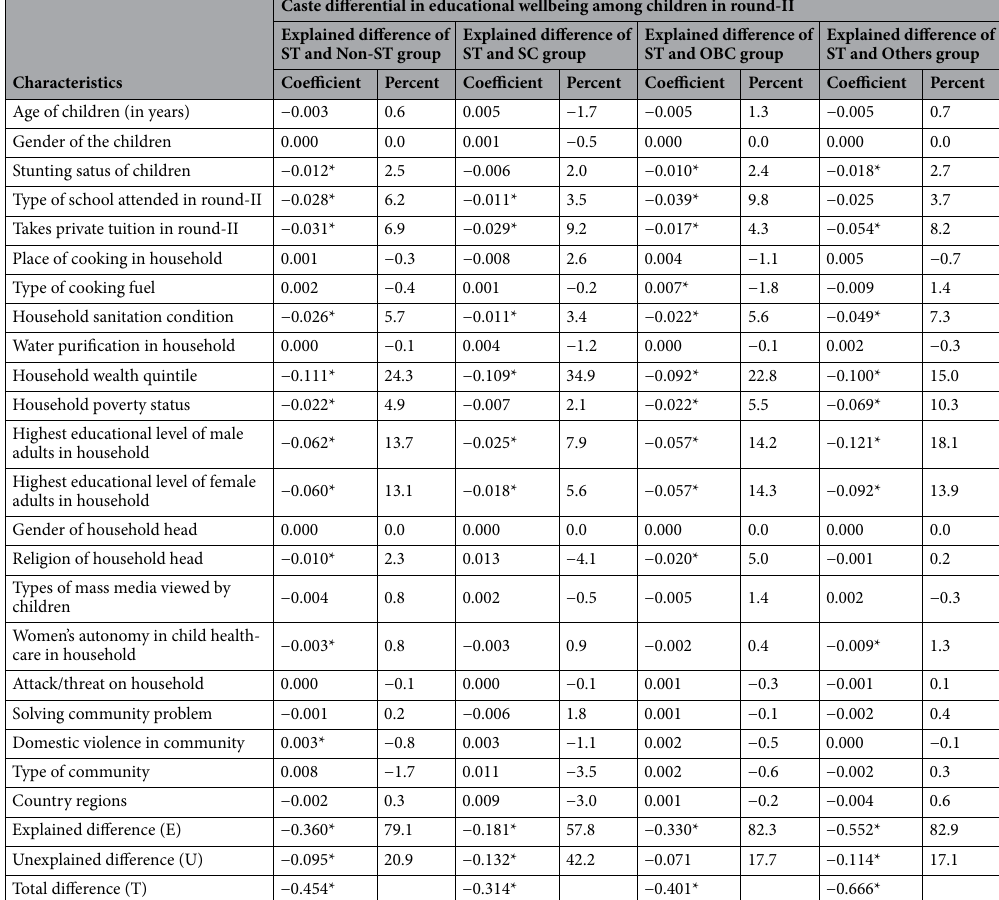
Table 5. Blinder-Oaxaca decomposition of the caste differential in educational wellbeing score between ST and Non-ST, ST and SC, ST and OBC, and ST and Others children for sensitivity analysis. (a) Statistical significance denoted by asterisks where *p-value <